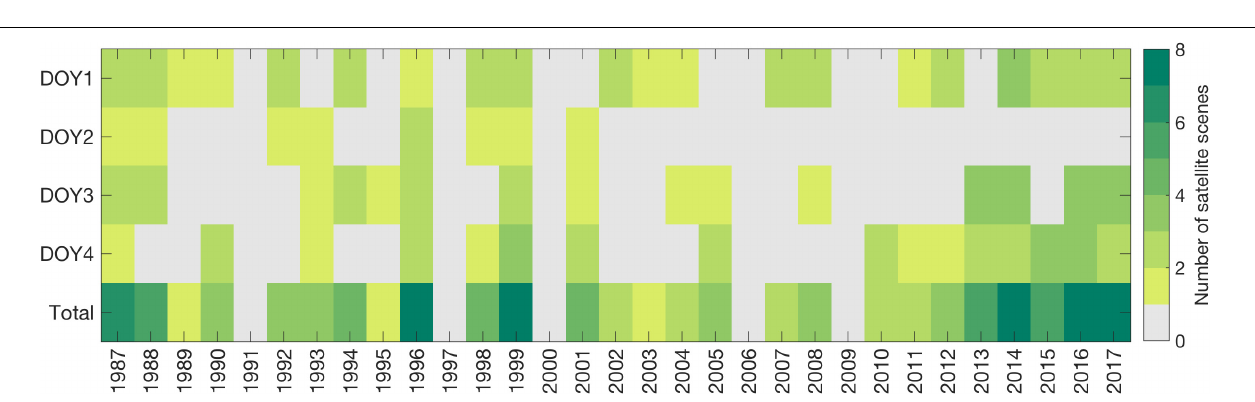
FIGURE 1 | Study region. The red outline depicts the extent of the Dhofar mountain study region, inset (a) shows its location on the Arabian Peninsula, inset (b) depicts a dry season, and inset (c) depicts post-monsoon vegetation.